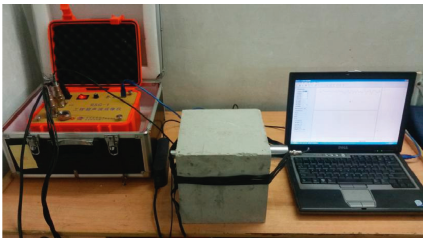
Figure 10: The nonlinear ultrasonic testing system.